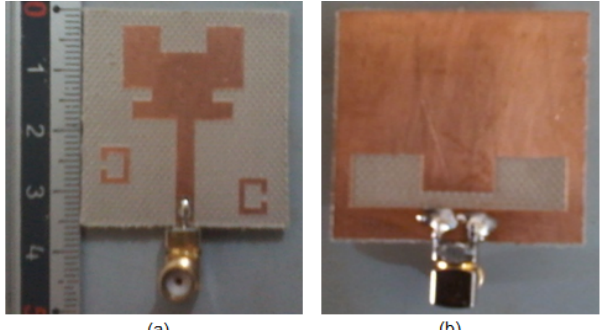
Figure 9. Photograph of fabricated prototype antenna (a) Front view and (b) Back view.